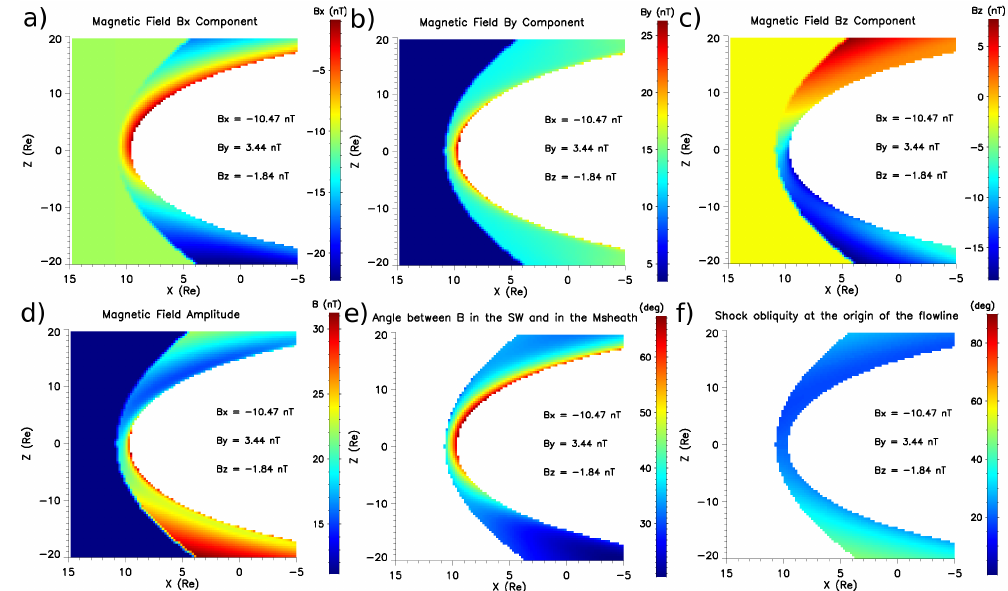
Fig. 8. Snapshots of the magnetosheath during an MC with its axis along z , encountered far from its centre, when the axis is located at x =1000 R E . The panels correspond to (a) B x , (b) B y , (c) B z , (d) B , (e) ψ , the angle between the magnetic field direction in the solar wind and in the magnetosheath, and (f) 2 Bn , the shock obliquity at the origin of the flowline.